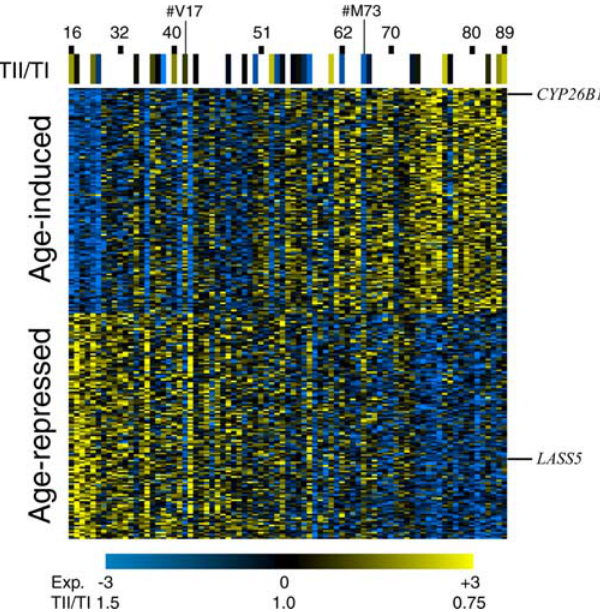
Figure 1. Expression of 250 Age-Regulated Genes in Muscle Rows correspond to individual genes, arranged in order from greatest increase in expression with age at top to greatest decrease in expression with age at bottom. Columns represent individual patients, from youngest at left to oldest at right. Ages of certain individuals are marked for reference. Scale represents log 2 expression level (Exp). Genes discussed in the text are marked for reference. A navigable version of this figure showing identities of specific genes can be found at http://cmgm. stanford.edu/ ; kimlab/aging_muscle. DOI: 10.1371/journal.pgen.0020115.g001